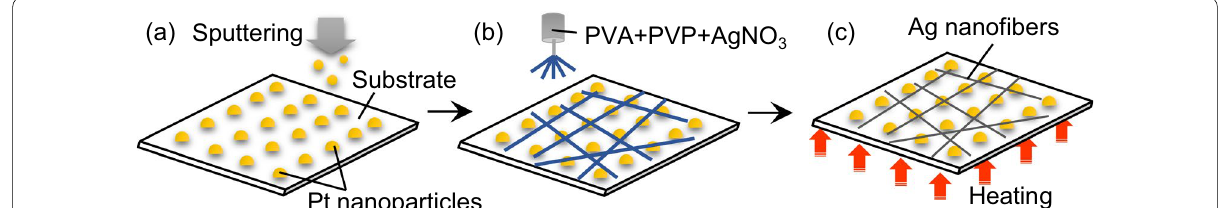
Fig. 1 Schematic showing the Ag NF network fabrication process: a Pt sputtering, b electrospinning of the AgNO 3 /PVA/PVP-mixed NF network, and c heating in